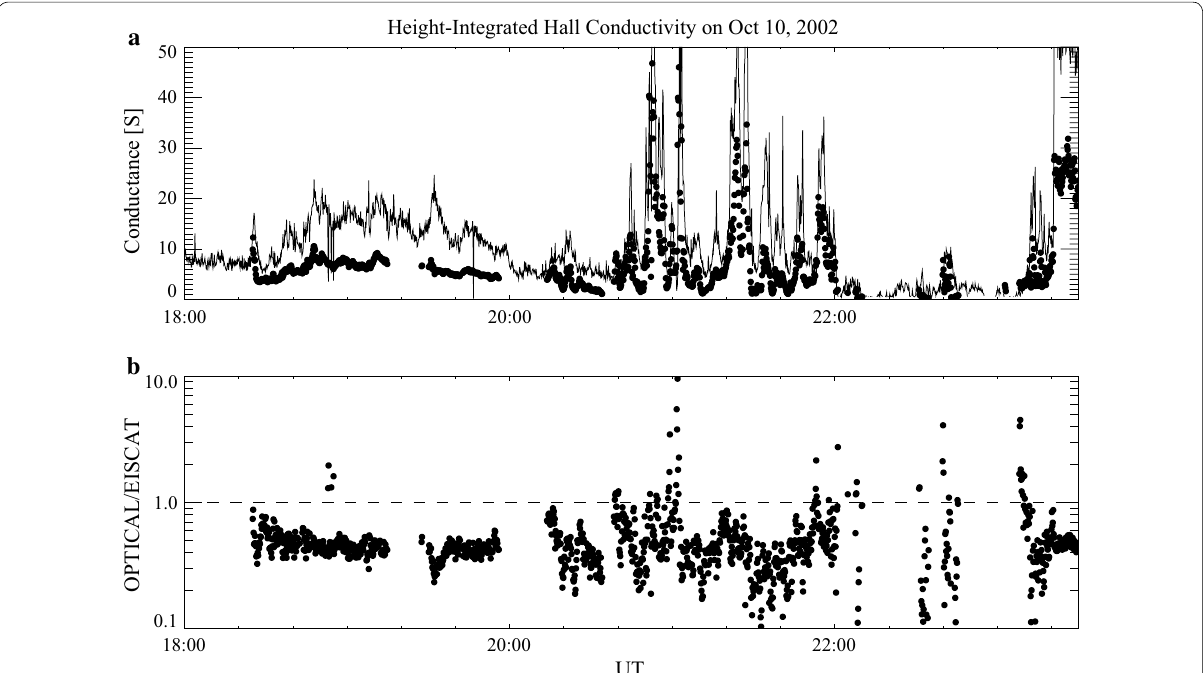
Fig. 5 Comparison of Hall conductivities for October 10, 2002; the same as Fig. 3 except for the height-integrated Hall